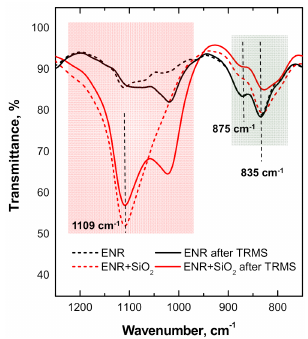
Figure 9. ATR-FTIR spectra for pristine (unfilled) ENR and ENR + SiO 2 composite before and after TRMS, in the range 1250–750 cm − 1